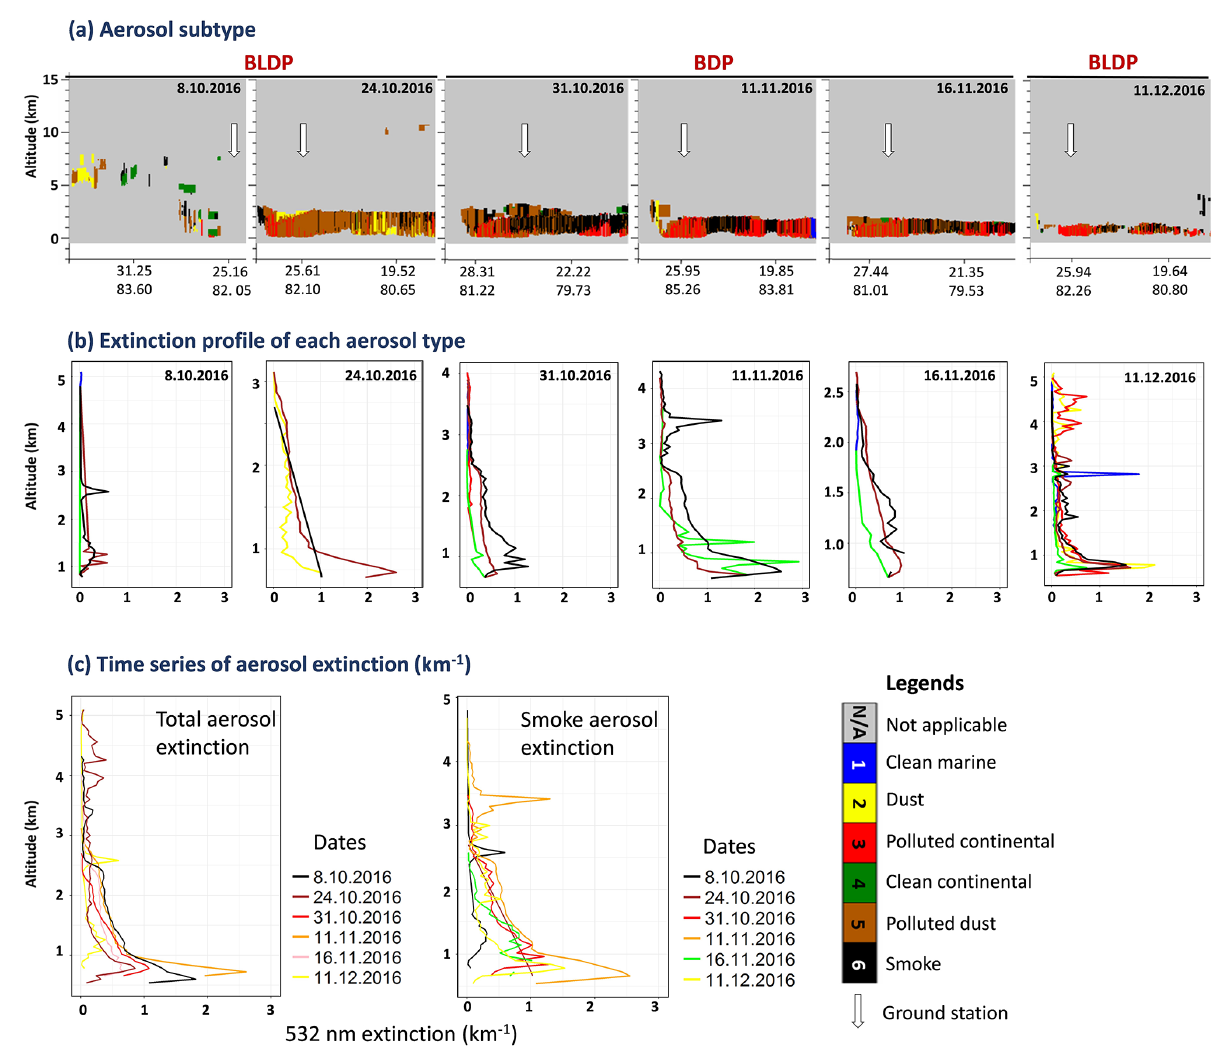
Figure 8. Aerosol vertical profiles from selected CALIPSO overpasses across ground station (a) aerosol subtypes, (b) extinction coefficients of each aerosol type, and (c) time series of the extinction profile for total and smoke